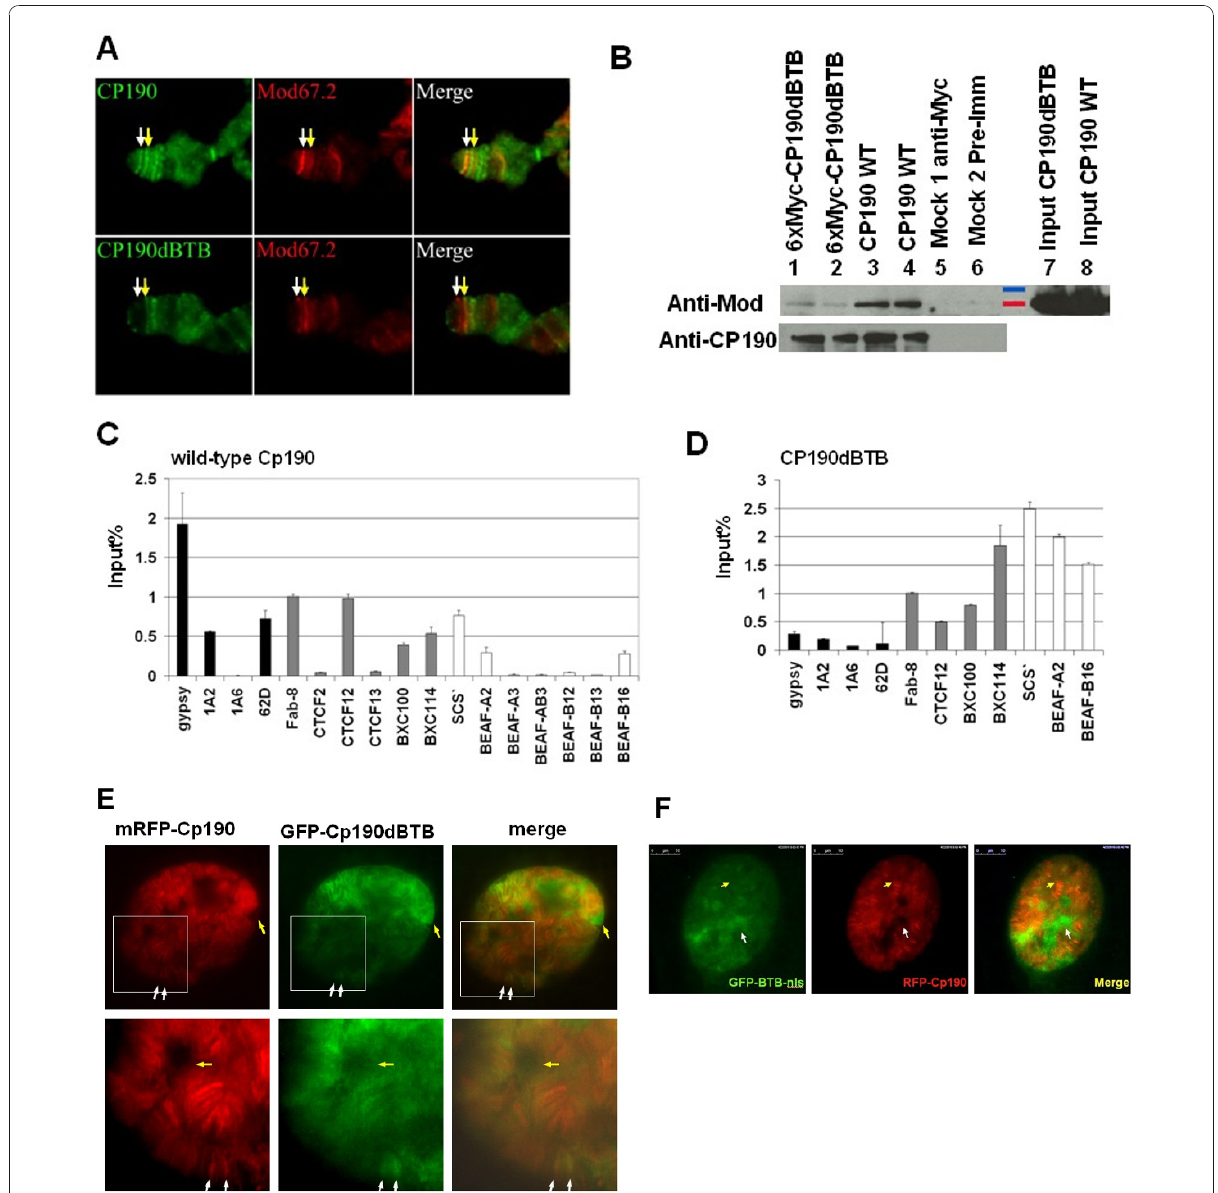
Figure 3 The BTB domain is necessary but not sufficient for association with the Su(Hw) complex . (A) Distribution of myc-CP190dBTB and Cp190 on polytene chromosomes. The polytene chromosomes of the y 2 (upper panel) and of the y 2 ; P[Ubi63e::myc-CP190dBTB]; CP190 P1 /CP190 3 (lower panel) flies were stained with anti-CP190 (left column) and anti-Mod(mdg4)67.2 (middle column). Shown are the tips of X chromosomes with the y locus (white arrows) and a band nears y (yellow arrows). (B) Co-immunoprecipitation of Cp190 and Mod(mdg4)67.2. Immunonblots of anti-Cp190 (top panel) and anti-Mod(mdg4)67.2 (bottom panel). Proteins were immunoprecipitated with anti-Myc from y 2 ct 6 ; P[Ubi63e::myc- CP190dBTB]/+; CP190 3 /TM6B pupae (lanes 1 and 2), with anti-Cp190 from y 2 ct 6 pupae (lanes 3 and 4), and with anti-Myc (lane 5) or pre-immune (lane 6) from y 2 ct 6 pupae. Input controls from myc-CP190dBTB (lane 7) and from y 2 ct 6 (lane 8) pupae. (C-D) Anti-Cp190 ChIP of known Su(Hw), CTCF, and BEAF32 loci assayed by Real-Time PCR (percentage of input DNA, n ≥ 3), from y 2 ct 6 flies (C) and from ct 6 ; P[Ubi63e::myc-CP190dBTB; CP190 3 /CP190 P1 flies (D). The 1A6 region is the negative control [12]. All results were normalized to Fab-8 . (E) Distribution of the mRFP-CP190 (red, left column), GFP-CP190dBTB (green, middle column) in a living salivary gland cell nucleus from a 3 rd instar larva. An extra-chromosomal space containing GFP-CP190dBTB signals but not mRFP-CP190 signals (yellow arrows). The closer views (bottom row) are crops indicated by the white squares in the upper row. The white arrows point to two bands containing both mRFP-CP190 and GFP-CP190dBTB. (F) Distribution of GFP- CP190BTB-nls (green, left) and mRFP-CP190 (red) in the cell nucleus of a living salivary gland from a 3 rd instar larva. The white arrows point an extra-chromosomal space containing GFP-CP190BTB-nls but not mRFP-CP190. The yellow arrows point to two mRFP-CP190 bands on polytene chromosomes that did not have detectable GFP-CP190BTB-nls